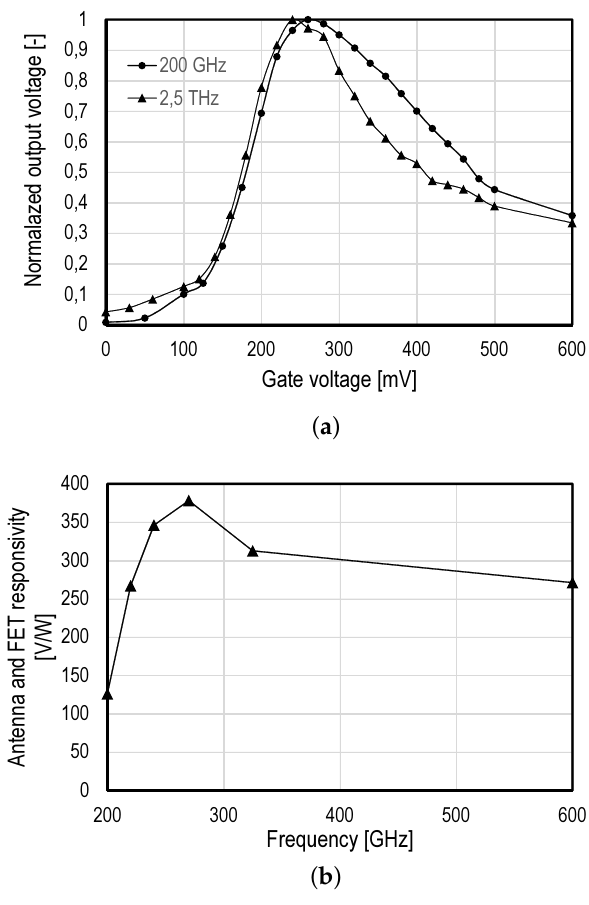
Figure 13. THz characterization of the sensor: ( a ) the amplitude of the output voltage, normalized to its maximum, over the gate bias for THz radiations at 200 GHz and 2.5 THz; ( b ) the measured responsivities for frequencies between 200 GHz and 600